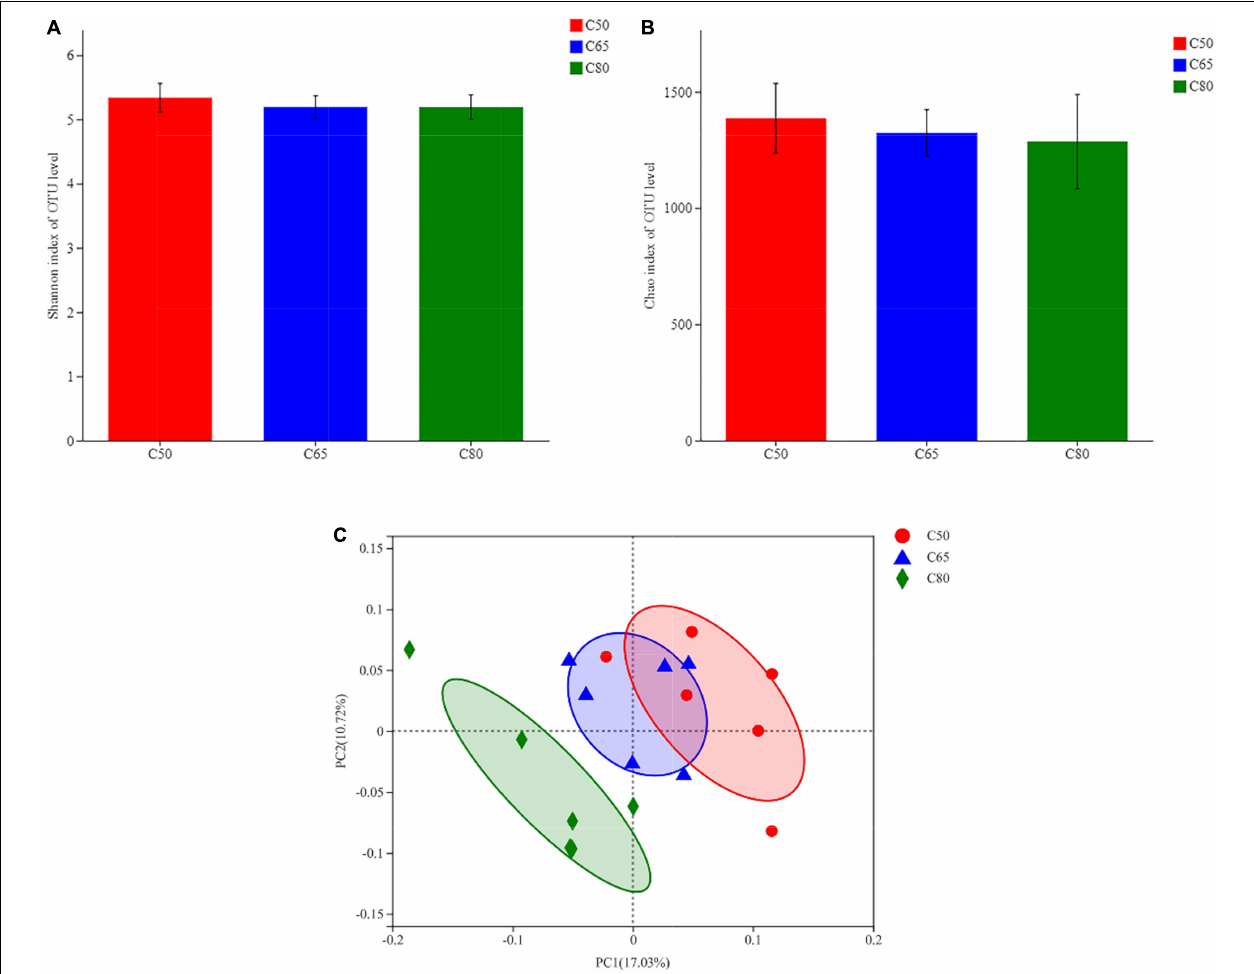
FIGURE 1 | Diversity and richness of bacterial communities. (A,B) Alpha diversity metrics. (A) Shannon and (B) Chao 1 indexes for rumen microbiota. (C) Plot of principal coordinate analysis. A shorter distance between the sample points denotes greater similarity of the bacteria. C50, dietary concentrate-to-forage ratio 50:50; C65, dietary concentrate-to-forage ratio 65:35; C80, dietary concentrate-to-forage ratio 80:20.